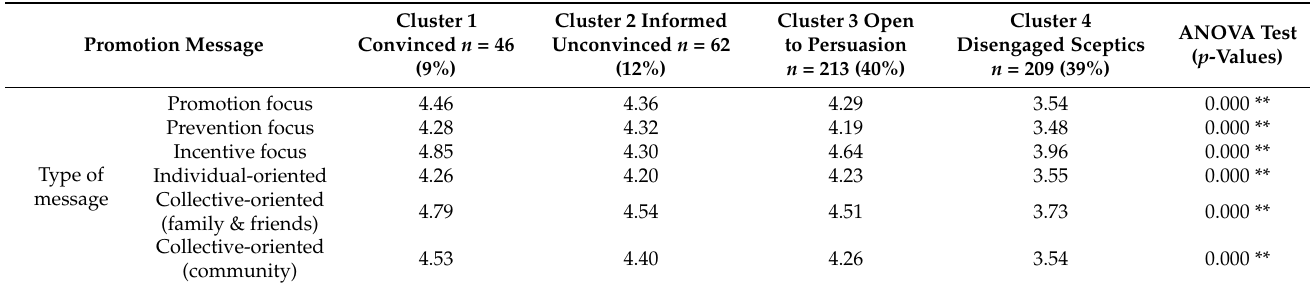
Table 7. Claimed effectiveness of message in motivating seasonal influenza vaccination by